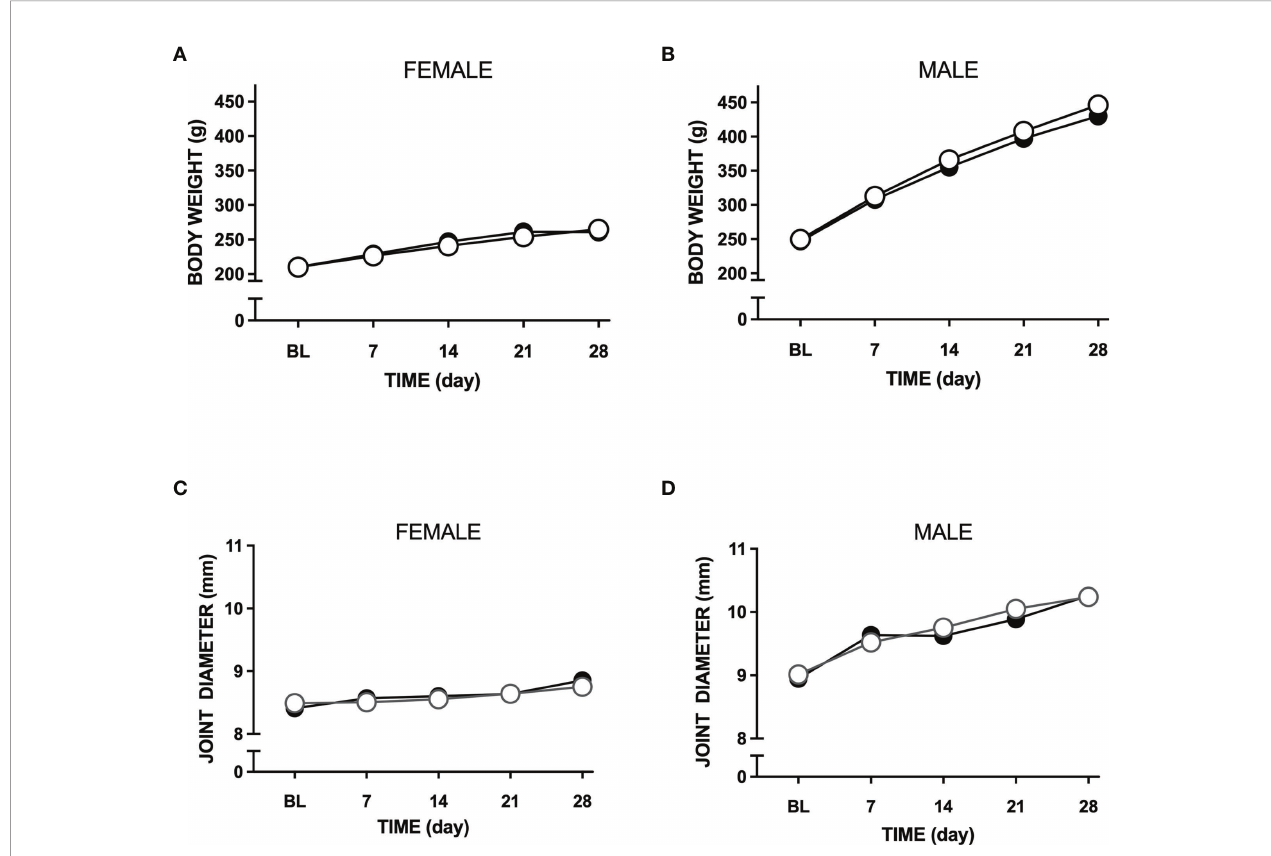
FIGURE 1 | Effect of LPA on body weight and joint oedema. Intra-articular injection of LPA (100µg) had no effect on body weight in either female (A) or male (B) rats. Animal growth progressed normally indicating that there were no systemic adverse effects of LPA treatment. Knee joint diameter was also unaffected by LPA treatment over the 28 day time period (C, D) con fi rming a lack of in fl ammatory oedema in the model. Data are means ±